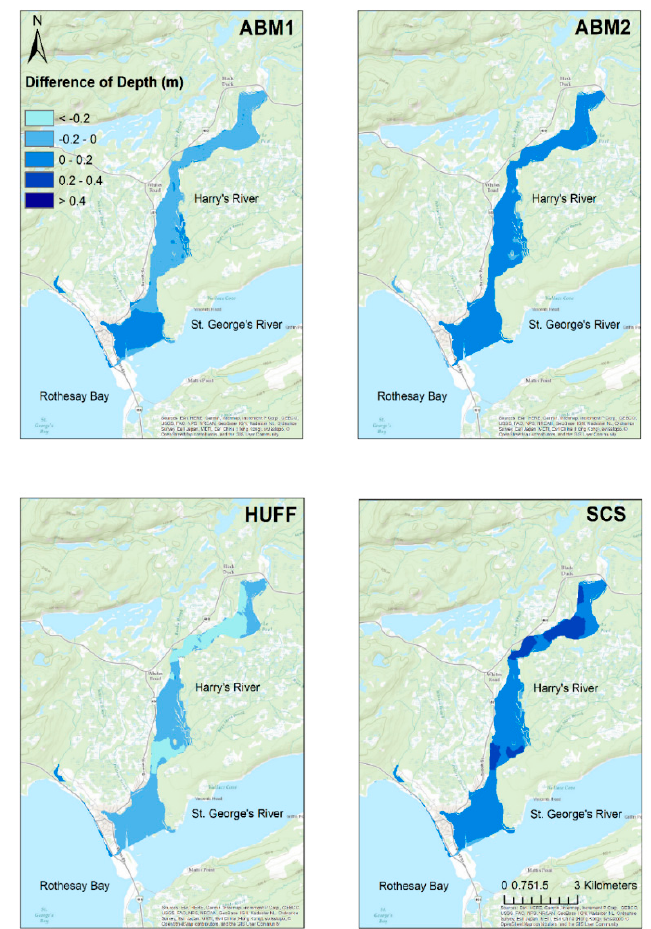
Figure 8. Relative changes in simulated maximum flood depths (m) between different design storm methods and the average of maximum depths from all methods. Results correspond to a 100-year event in the 2050s based on WRF-IDF under the RCP8.5 emission scenario.